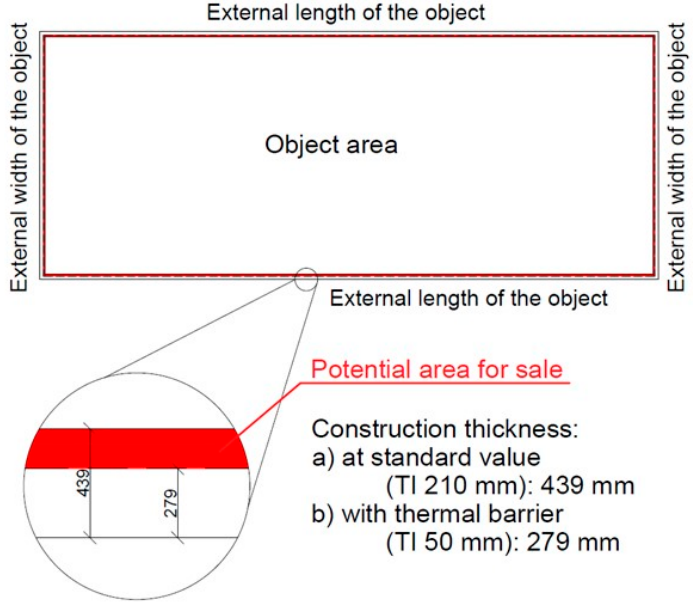
Figure 14. Increasing the potential area of the building for sale for a facade with 50 mm thermal insulation and a thermal barrier compared to a normative facade with 210 mm thermal insulation.